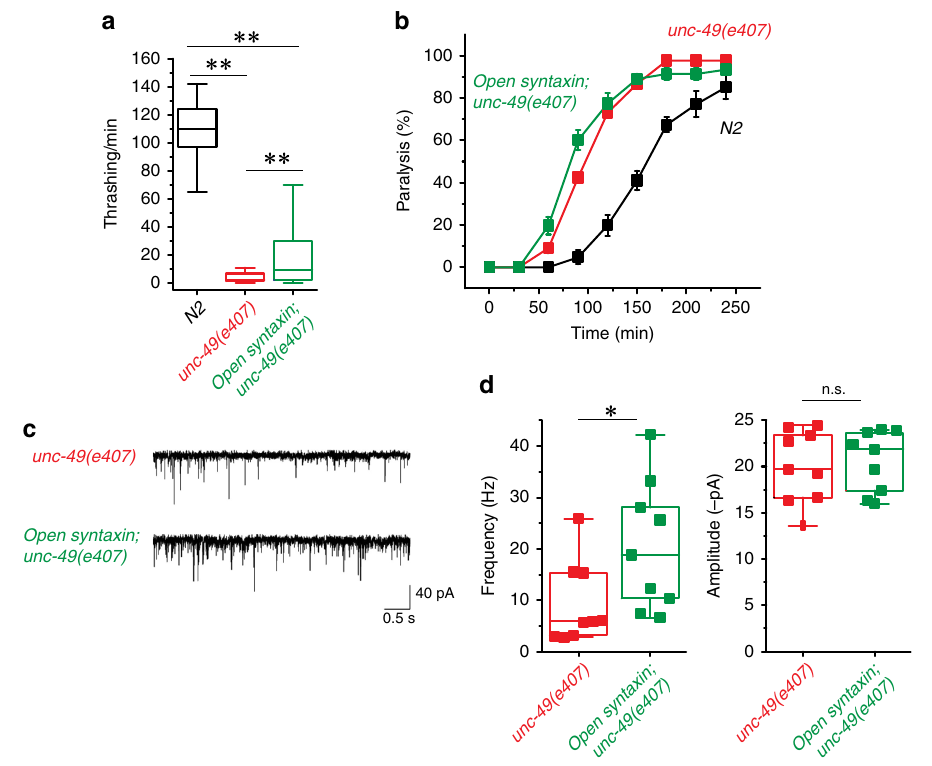
Fig. 9 The knock-in open syntaxin mutation enhances exocytosis in GABA receptor mutants. a Box-and-whisker plots of thrashing assay for N2, unc-49 (e407) , and open syntaxin; unc-49(e407) double mutants in M9 buffer. unc-49(e407) worms displayed greatly reduced thrashing rates (5.73 thrashes/min), which was rescued by the introduction of open syntaxin in the double mutant (17.05 thrashes/min). n = 40 for each strain. In one-way ANOVA statistical tests, F (2,117) = 335 and p = 0.00. Tukey ’ s test was performed for means analysis in ANOVA. For all comparisons, ** p = 0.00. b Aldicarb assays of N2, unc- 49(e407) , and open syntaxin; unc-49(e407) double mutants. unc-49 animals displayed hypersensitivity to aldicarb (gray), which was further enhanced in the double mutant (black). n = 6. Each assay was conducted with 15 – 20 worms. Error bars represent SEM. c Representative mEPSC traces recorded from N2, unc-49(e407) , and open syntaxin; unc-49(e407) worms. d Box-and-whisker plots overlaid with the corresponding data points (squares) of mEPSC frequency (left) and amplitude (right) of N2, unc-49(e407) , and open syntaxin; unc-49(e407) worms. Two-sample two-sided t -test, * p = 0.04; n.s. p = 0.75. n = 9 for unc-49(e407) and open syntaxin; unc-49(e407) animals. Box-and-whisker plots represent the median (central line), 25th – 75th percentile (bounds of the box), and 5th – 95th percentile